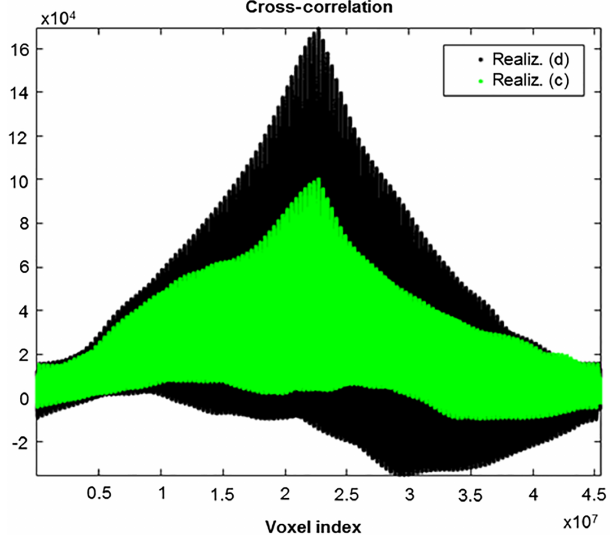
Figure 19. Cross-correlation between the soft probability distribu- tion (Fig. 9) and each of the realizations shown in Fig. 15c (re- alization c) and Fig. 15d (realization d), and described in Table 1 (strategies c and